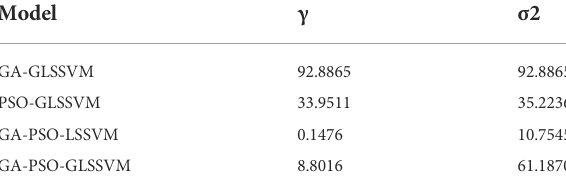
TABLE 3 Optimal parameter combinations of different